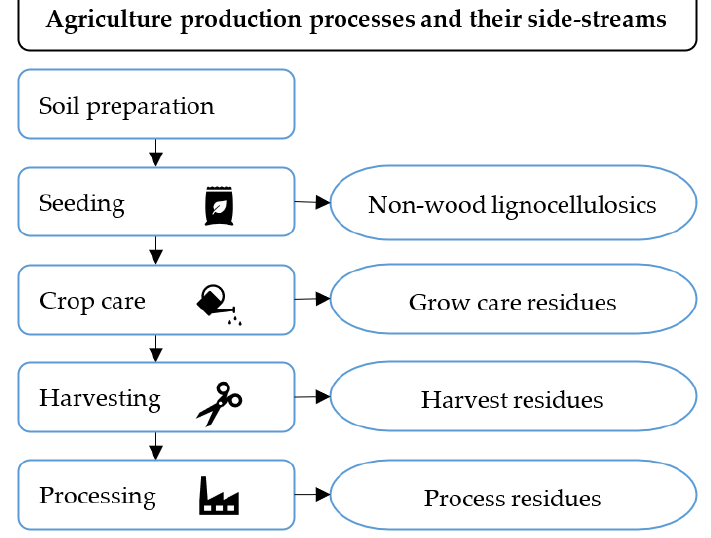
Figure 2. Different agriculture production processes and their related available side ‐ streams.